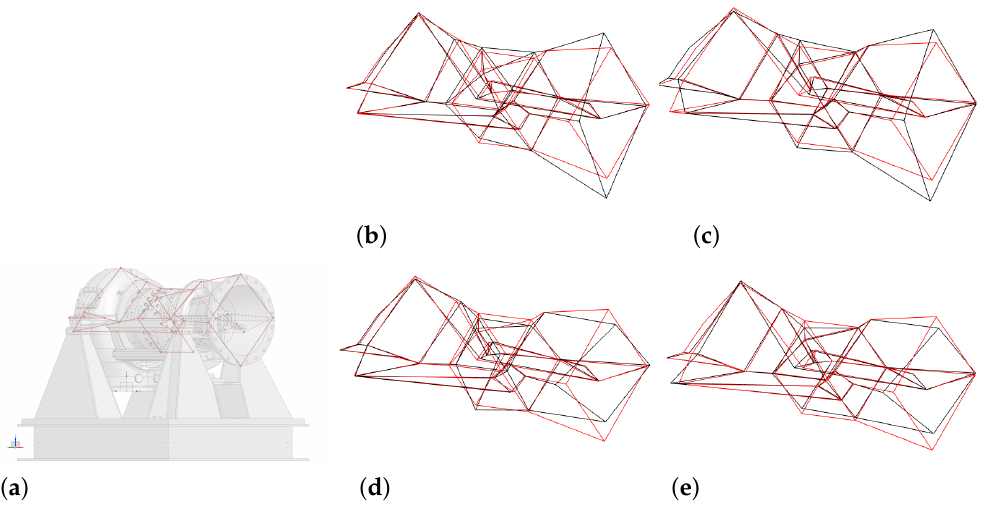
Figure 6. ( a ) Compressor with grid lines for mode shape animation. ( b , d ) Mode shape for mode 1 at 491 Hz. ( c , e ) Mode shape for mode 2 at 545 Hz. Mode shapes gained from OMA for the speed 1 Ref case. Table 3. Selected, robust eigenfrequencies in operation (Asb1).